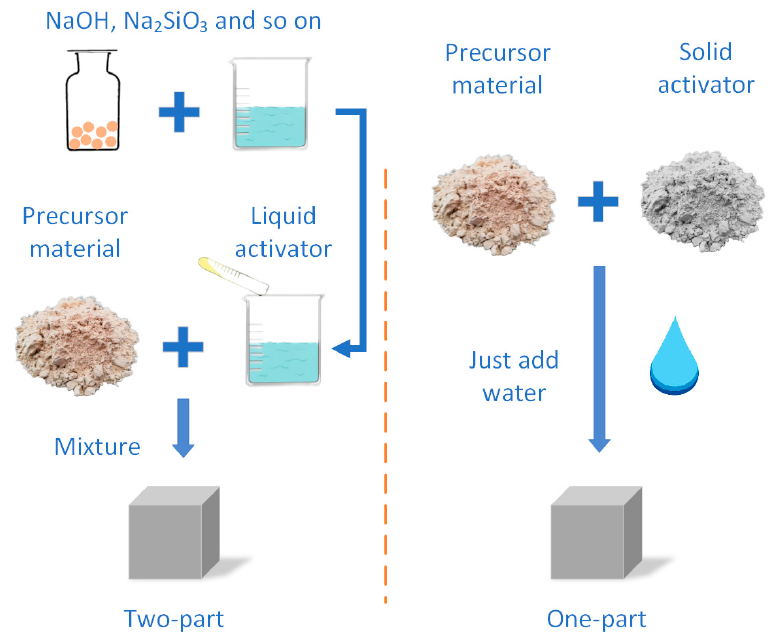
Figure 3. Schematic representation of different preparation processes.